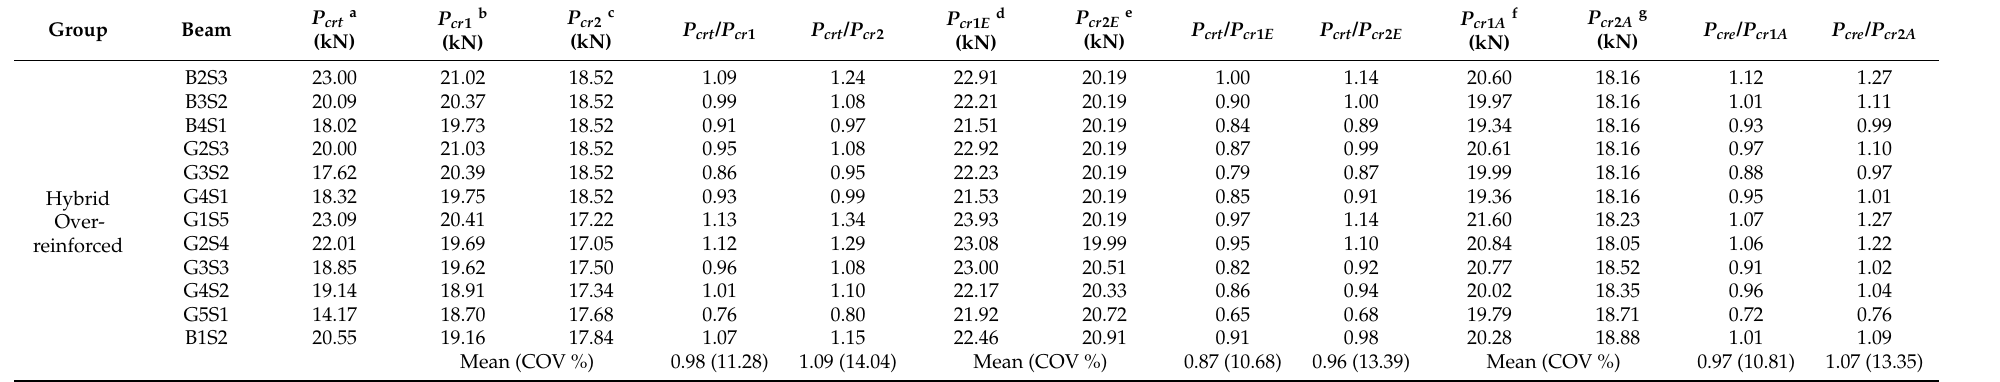
Table 3. Experimental and estimated cracking load values of RC specimens with hybrid FRP-steel